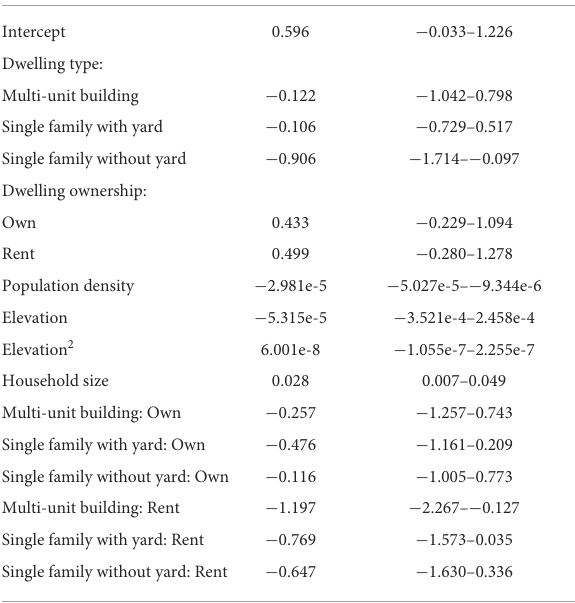
TABLE 4 Parameter estimates and 95% confidence interval of the top model to explain the number of dogs per household owned by residence of Costa Rica.